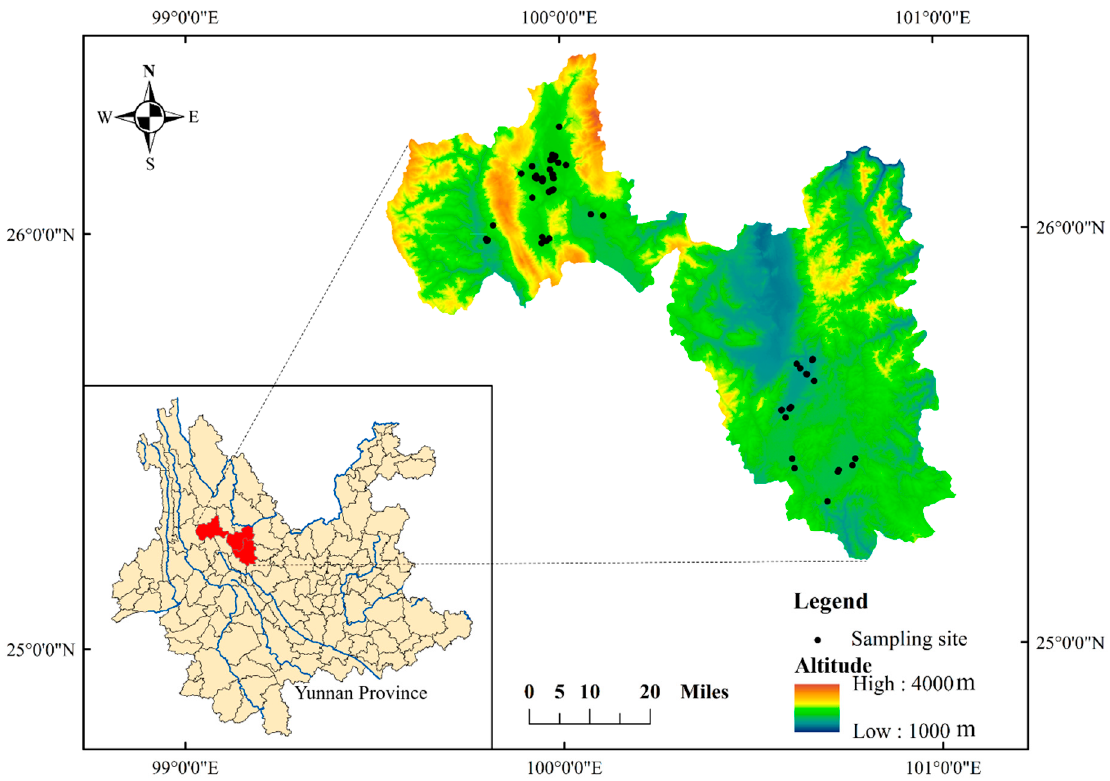
Figure 1. Location of the sampling sites in Yunnan Province, China.